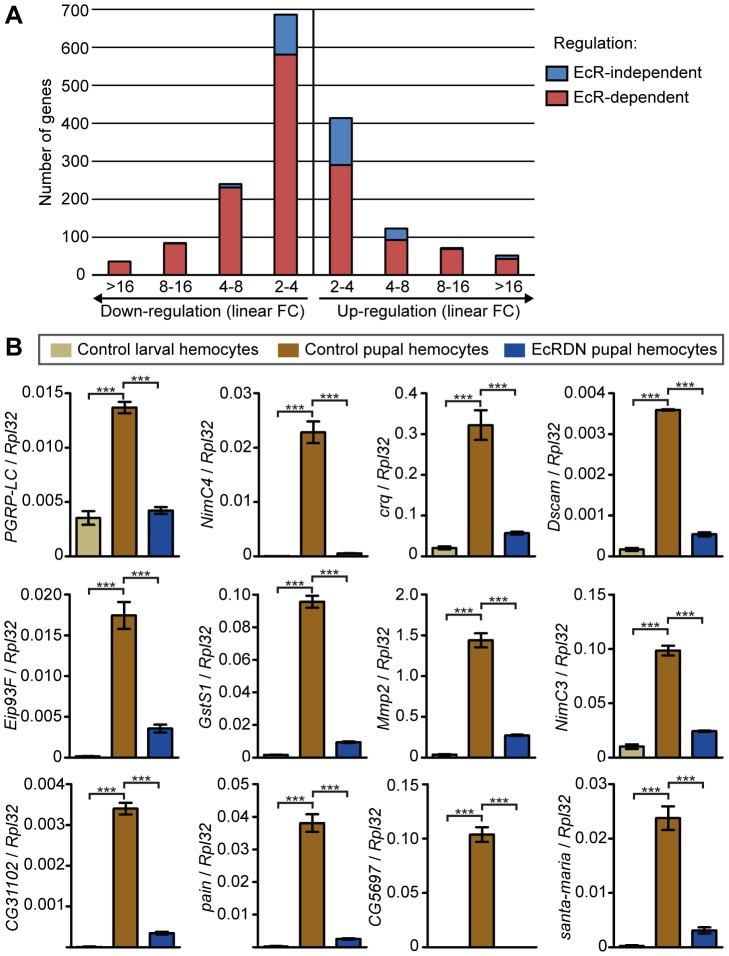
Transcriptomic analysis of the impact of ecdysone signaling on hemocytes at metamorphosis.(A) Distribution of the hit genes per fold change and per dependence to EcR. Genes whose expression is significantly (p<0.001) changed in hemocytes between late feeding larval 3rd instar and early prepupae (1 h–2 h APF) were identified by microarrays and classified based on FC. FC Indicated are linear and only genes which FC>2 are represented on this figure. Up- or down-regulation of a gene was defined to be EcR-dependent when its expression was significantly altered in EcRB1DN-expressing pupal hemocytes (p<0.001; see Table S1 for gene list). (B) qPCR confirmation of the expression of 12 genes from the microarrays. qPCR was performed on RNA extracted from FACS-sorted hemocytes. The results displayed represent the mean and SEM of three biological repeats; samples were independent from samples used for microarrays. Statistical analysis was performed using one-way ANOVA and Tukey-Kramer post-test. For comparison between control larval hemocytes and control pupal hemocytes, as well as between control pupal hemocytes and EcRDN pupal hemocytes, significance are indicated on the graph. There was no significant difference between control larval hemocytes and EcRDN pupal hemocytes except for GstS1 (*), NimC3 (*), Mmp2 (*) and Dscam (***).